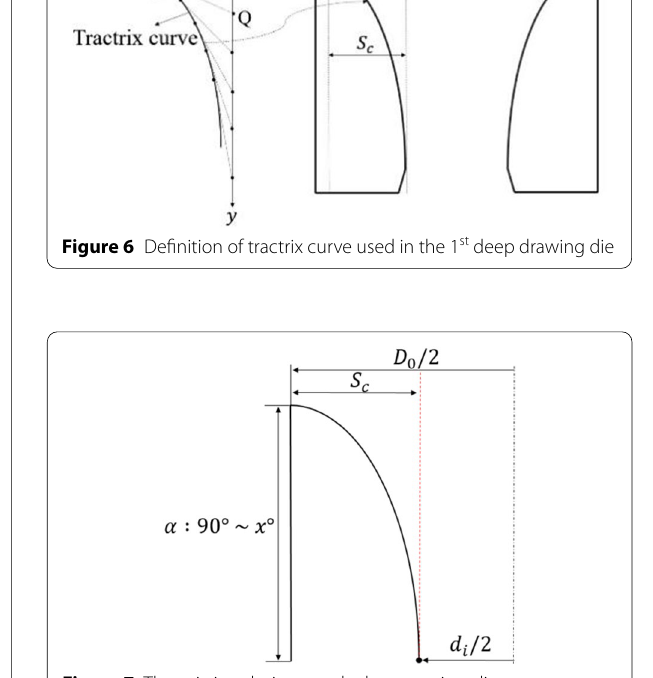
Figure 7 The existing design to calculate tractrix